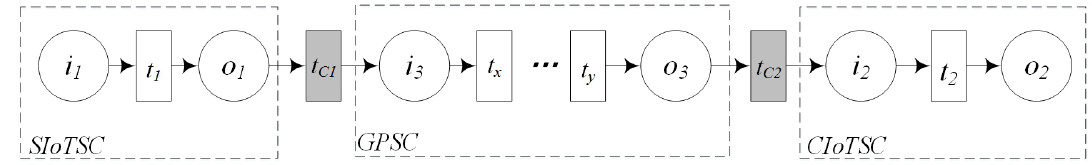
Figure 13. CPN model of GIS-oriented IoT service application.